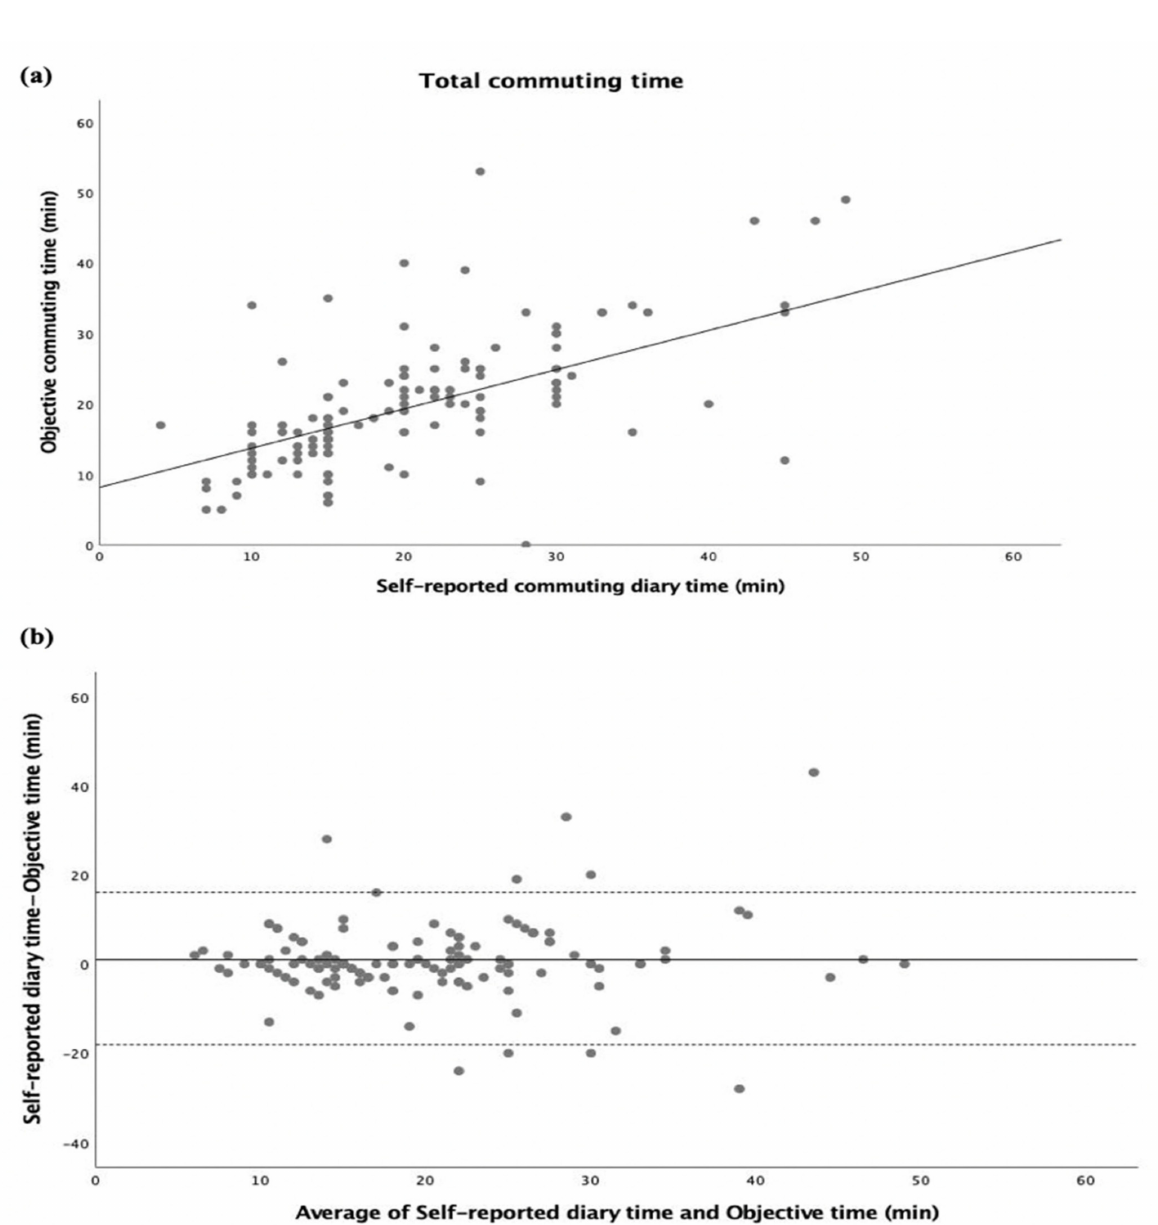
Figure 1. Commuting time expressed as minutes (total commuting time). ( a ) Regression of the objective commuting time (y) vs. (x) the self-reported commuting diary time. The regression equation is y = 8.18 + 0.56x. ( b ) Bland–Altman plot of the total commuting time between self-reported diary time and objective time (y) vs. average of self-reported diary time and objective time (x). The central dotted line represents the mean of differences between the self-reported time measure and the objective time measure; the upper and lower dotted lines represent the upper and lower 95% limits of agreement (mean differences ± 1.96 standard deviations of the differences),